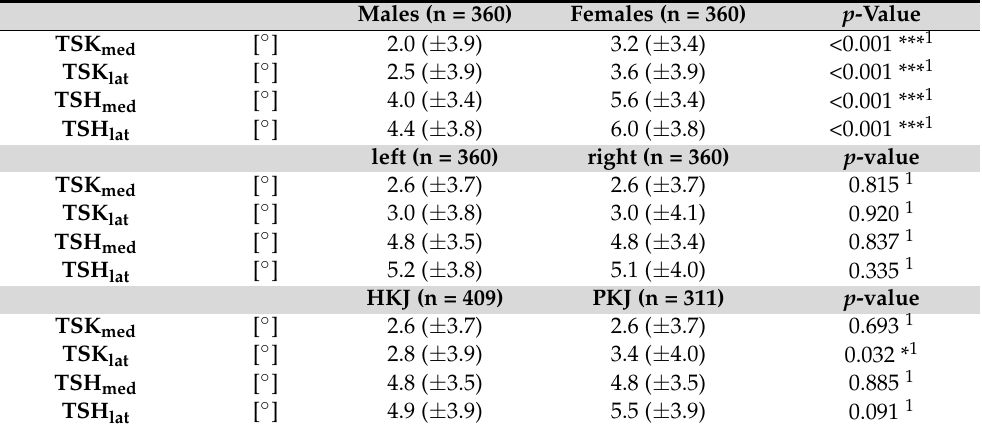
Table 2. Gender- and side-specific analysis of TSK med , TSK lat , TSH med and TSH lat and comparison between HJK and PKJ (*** p < 0.001, * p <